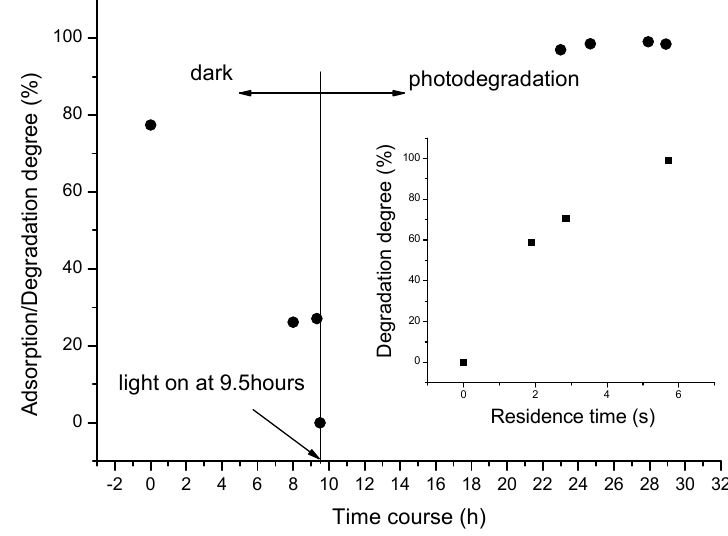
Figure 2. The time course of degree of adsorption/degradation, in humid air with a relative humidity of about 25%, benzene inlet concentration of about 100 g/m 3 .